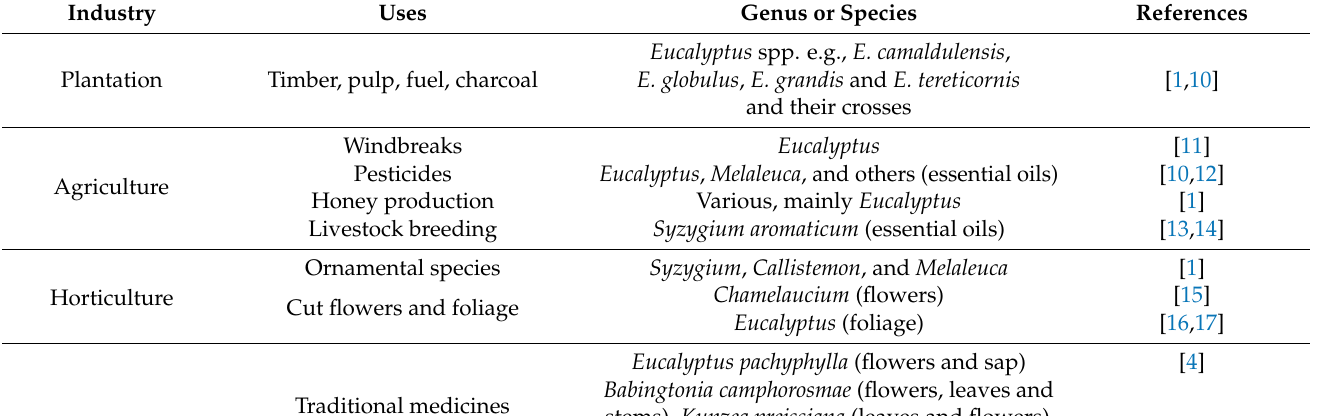
Table 1. Recorded variety of uses for Myrtaceae species in different